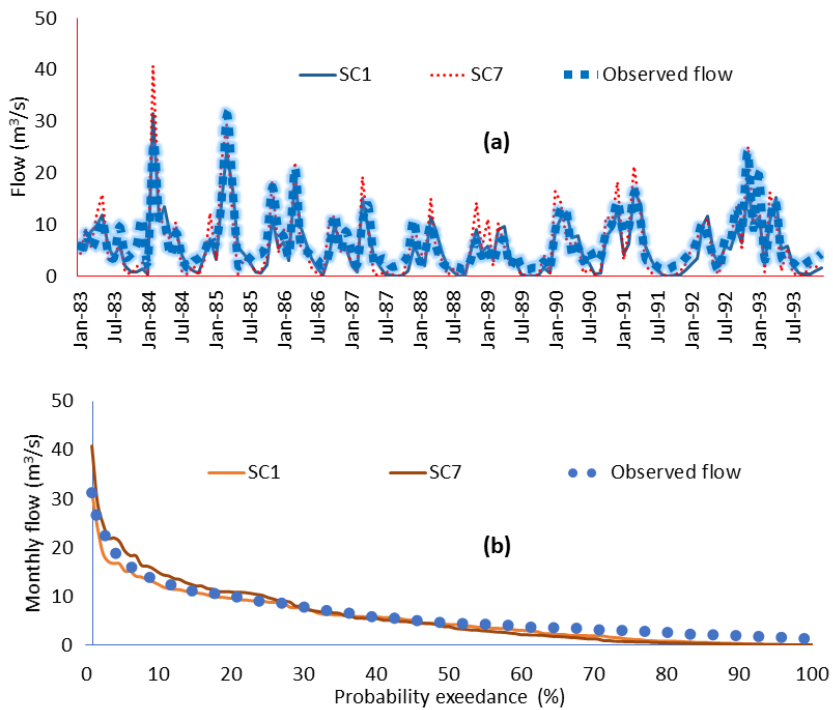
Figure 10. Annual hydrologic balance components: ( a ) comparison of scenarios SC1 and SC7 FAO soil with combination of Solaris (land use) and GCDC weather. ( b ) Comparison of scenarios SC4 and SC10 FAO soil with combination of GLCC (land use) and GCDC weather.